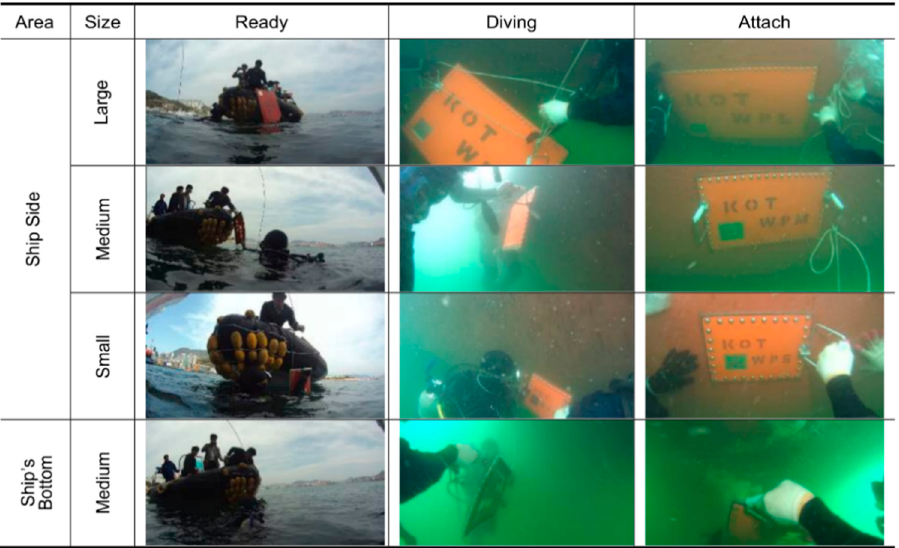
Figure 6. Attaching emergency magnetic liquid spill stoppers to the ship for attachment tests [36].